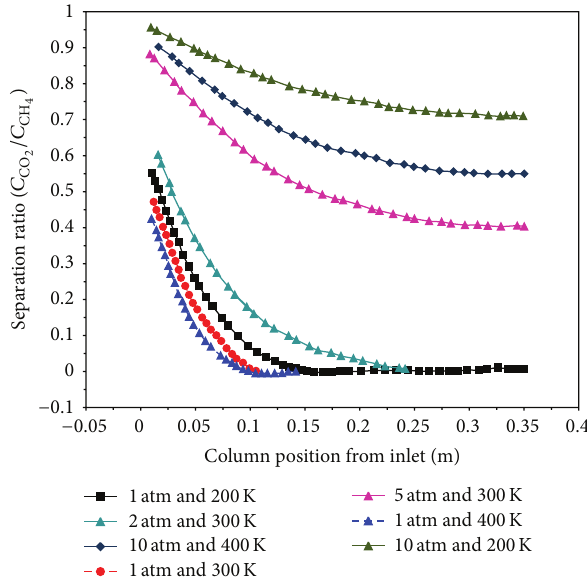
Figure 7: Optimization studies on separation ratio on operation conditions (feed velocity = 0.001m/s).